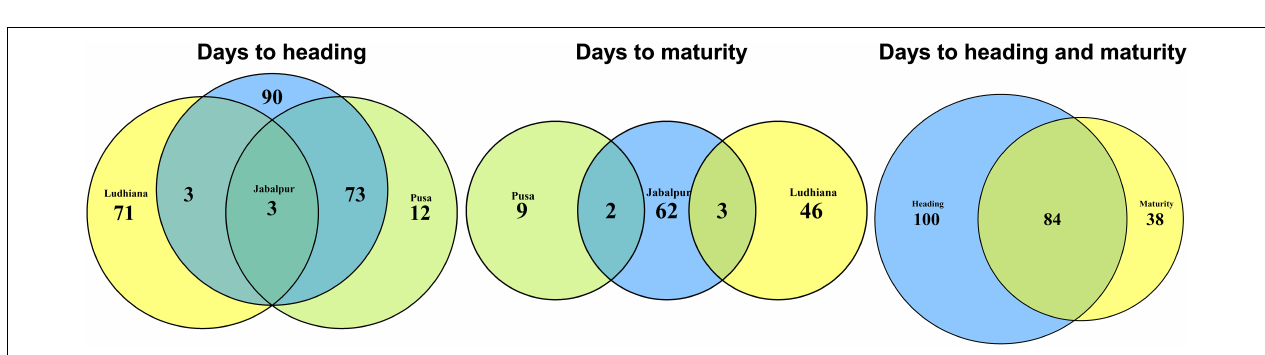
FIGURE 6 | Manhattan plots showing the genomic regions significantly associated with days to heading (DH) and maturity (DM) in Pusa in panels 2014–2021.